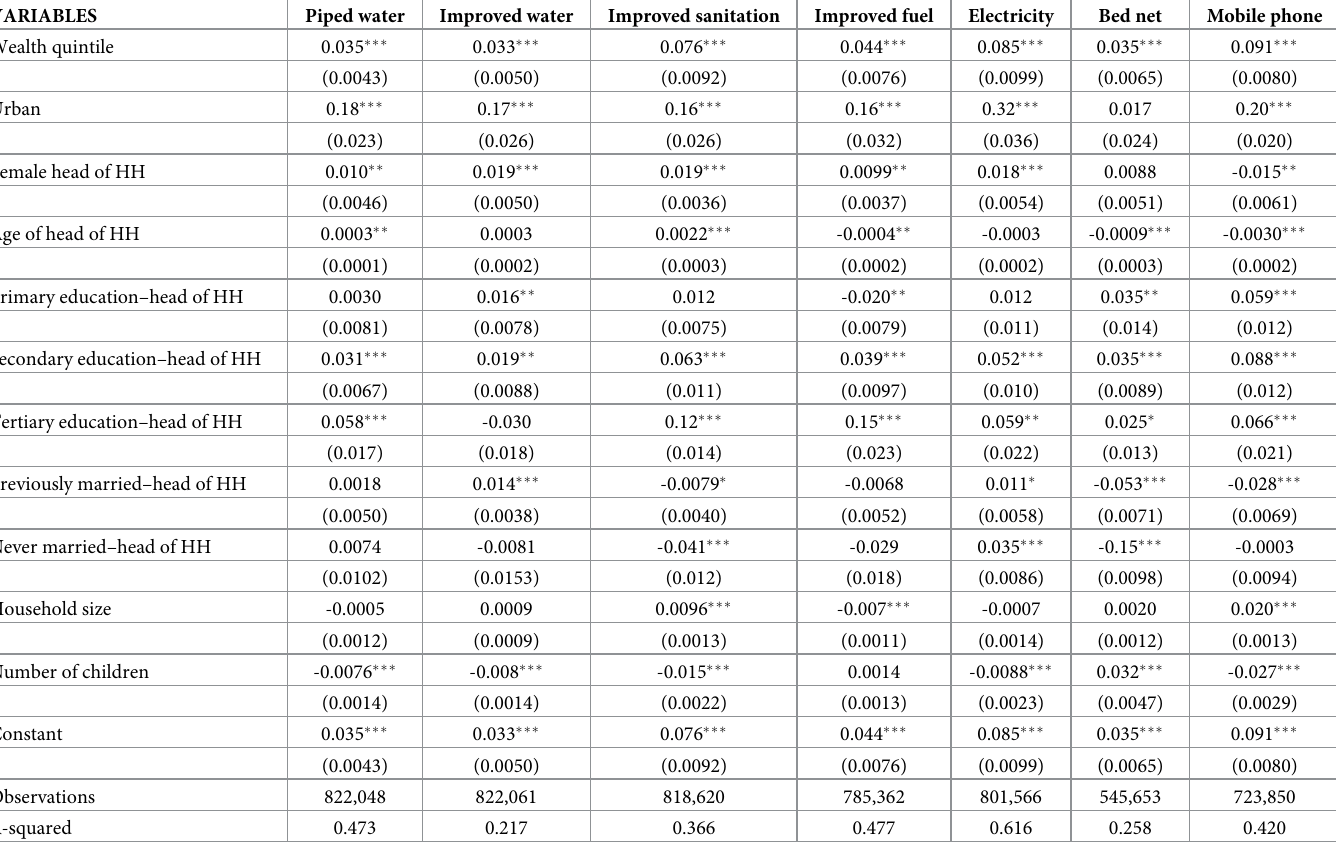
Table 3. Pooled multivariable regression estimates of the association between wealth and EHA